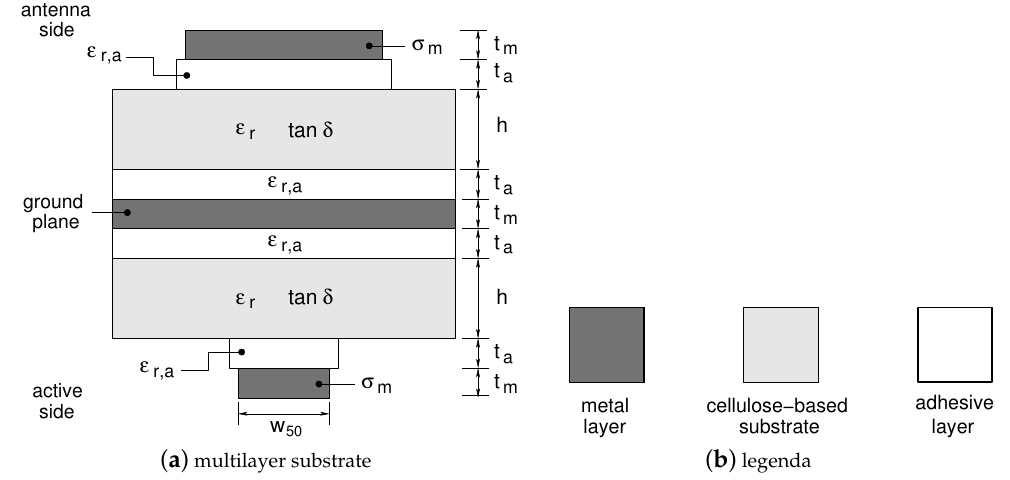
Figure 3. Multilayer substrate. ( a ) Cross-section of the multilayer substrate structure adopted for the fabrication of the 24-GHz radar front-end. ( b ) Materials. Bulk copper with conductivity σ m = 5.8 × 10 7 S/m is adopted to implement all the metal layers. The substrate parameters as follows: h = 230 µ m, t a = 30 µ m, t m = 35 µ m. The photo-paper and the acrylic adhesive relative permittivity are: ε r = 2.9 and ε r , a = 1.3 respectively. The photo-paper loss tangent is: tan δ =